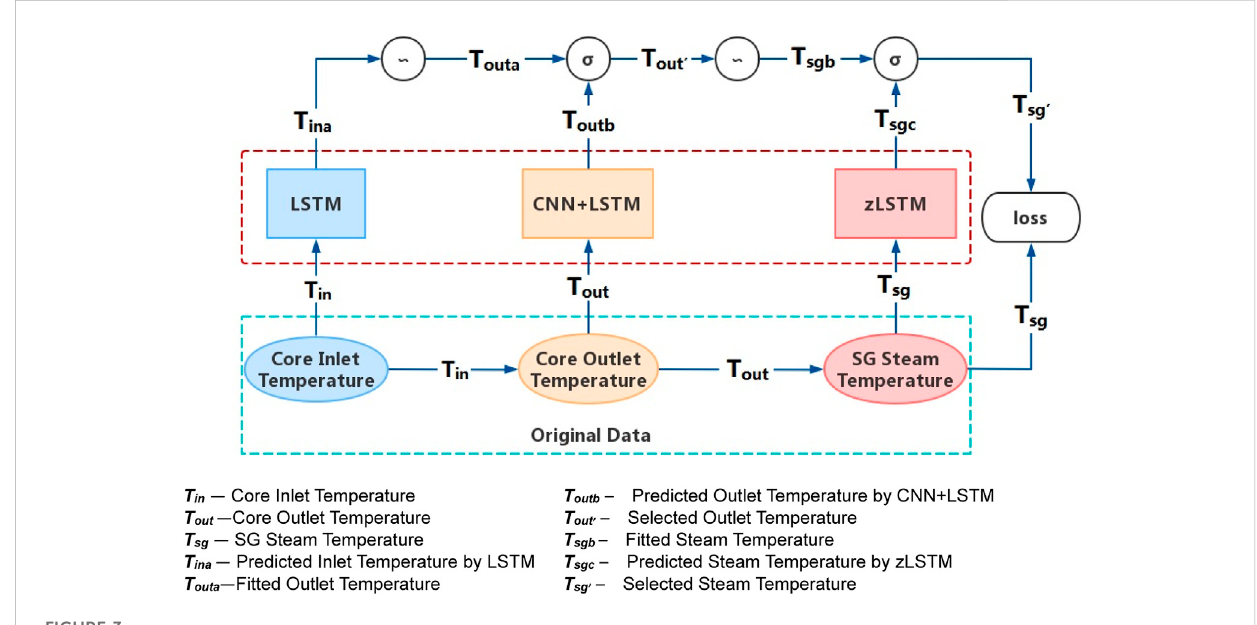
FIGURE 3 Multi-node operation condition prediction